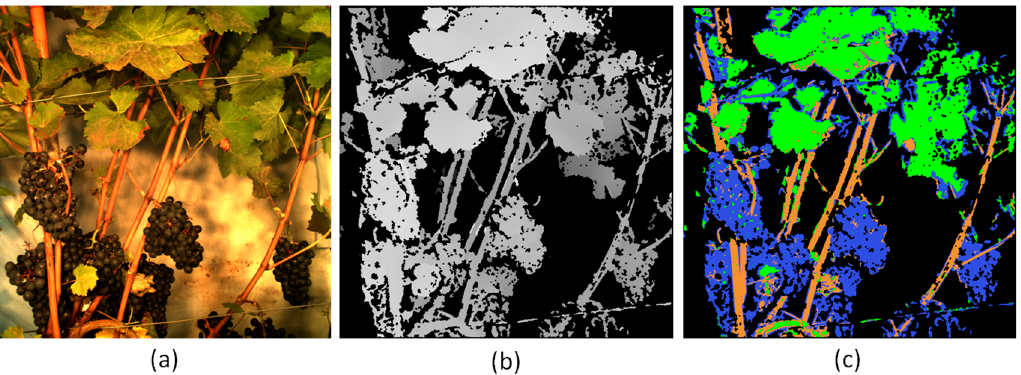
Figure 6. ( a ) Rectified image acquired with Sensor A (camera (5), only overlapping part of stereo pair shown). ( b ) Depth map calculated with stereo pair from camera (3) and camera (5). The brightness indicates the distance to the cameras (white for near points, dark gray for far points). Black pixels indicate positions with no depth which can be assumed to be background. ( c ) First result of a test for classification with manually set thresholds. The RGB image from ( a ) and the depth map from ( b ) are used as input. Classes are: blue for “grapes”, green for “canopy”, brown for “cane”, black for “background”.